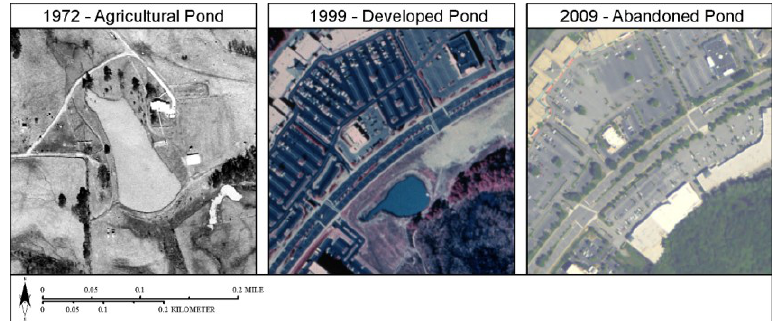
Figure 8. Example of small reservoir and surrounding land cover change from agricultural to developed to abandoned (in this example, paved